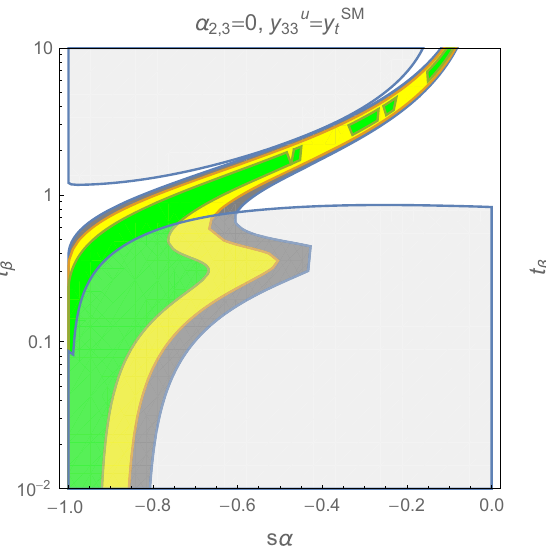
= y SM / cos β in the right panel. m and y u t 33 m A = 140 GeV and v s = 1 TeV has been taken in all = y SM t in the left 33